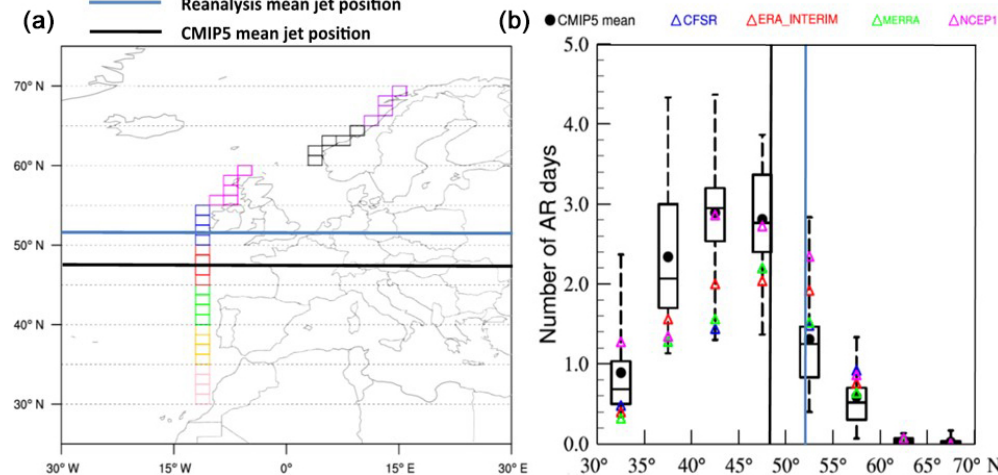
Figure 5. Atmospheric rivers (ARs) are responsible for over 90% of the moisture transport to the extratropics (Zhu and Newell, 1998). They also contribute significantly to heavy precipitation and flooding in many regions worldwide (Ralph et al., 2006). Understanding how ARs may change in a warmer climate is important for managing water resources and flood risk. Associated with Rossby wave breaking, the frequency of ARs and their landfall locations are influenced by the jet stream. Global climate models in the Coupled Model Intercomparison Phase 5 (CMIP5) exhibit an equatorward bias in the simulated jet position. For example, panel (a) shows the grid boxes (colored) used to detect CMIP5 model-simulated North Atlantic ARs making landfall in Europe. The black and blue horizontal lines show the CMIP5 and reanalysis mean jet positions, respectively. The CMIP5 models simulate a mean jet stream position that is almost 5 ◦ equatorward of that depicted in the reanalysis, probably due to their relatively coarse model resolutions (e.g., Lu et al., 2015). Biases in the jet position have important implications for the simulation of ARs in Europe. As shown in panel (b) , CMIP5 models simulated too few (too many) ARs poleward (equatorward) of the observed jet position in the North Atlantic during December–February compared to four global reanalyses (color symbols). Here, the box-and-whisker plots show the CMIP5 multi-model mean (dot), median (horizontal bar), 75 and 25% percentiles (upper and lower boundaries of the box), and the highest and lowest values (whiskers). A challenge for improving the simulation of ARs and their response to warming is the more accurate simulation of the jet stream and the associated Rossby wave dynamics. Enabled by advances in computational resources, increasing model resolution may improve the fidelity of model-simulated jet, which may improve projections of changes in extreme precipitation and flooding in a changing climate. (Contact: Ruby Leung. See Gao et al. (2016) for more